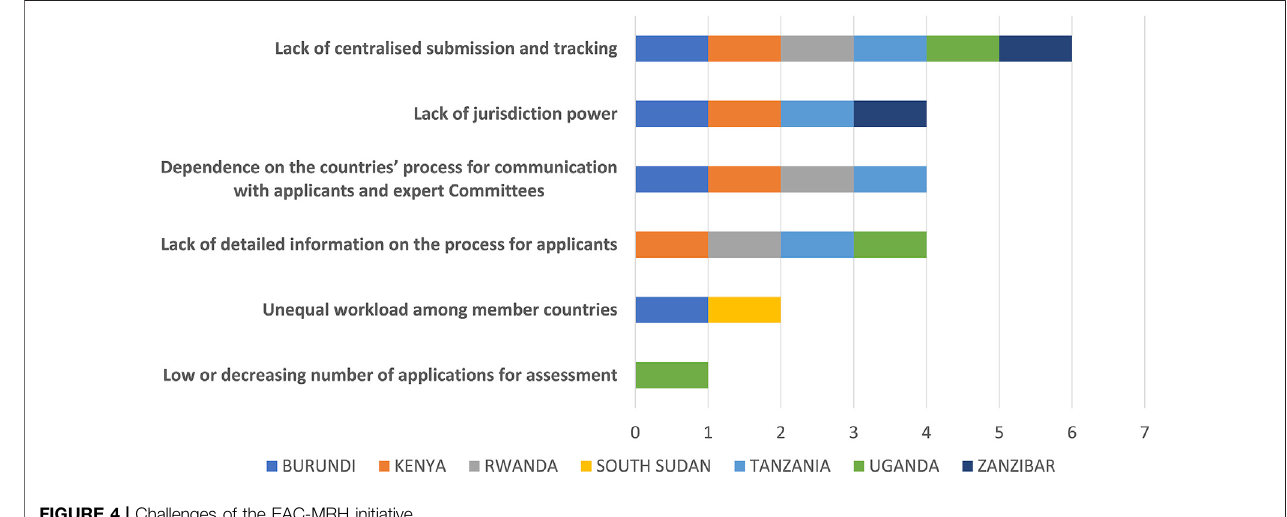
FIGURE 4 | Challenges of the EAC-MRH initiative.